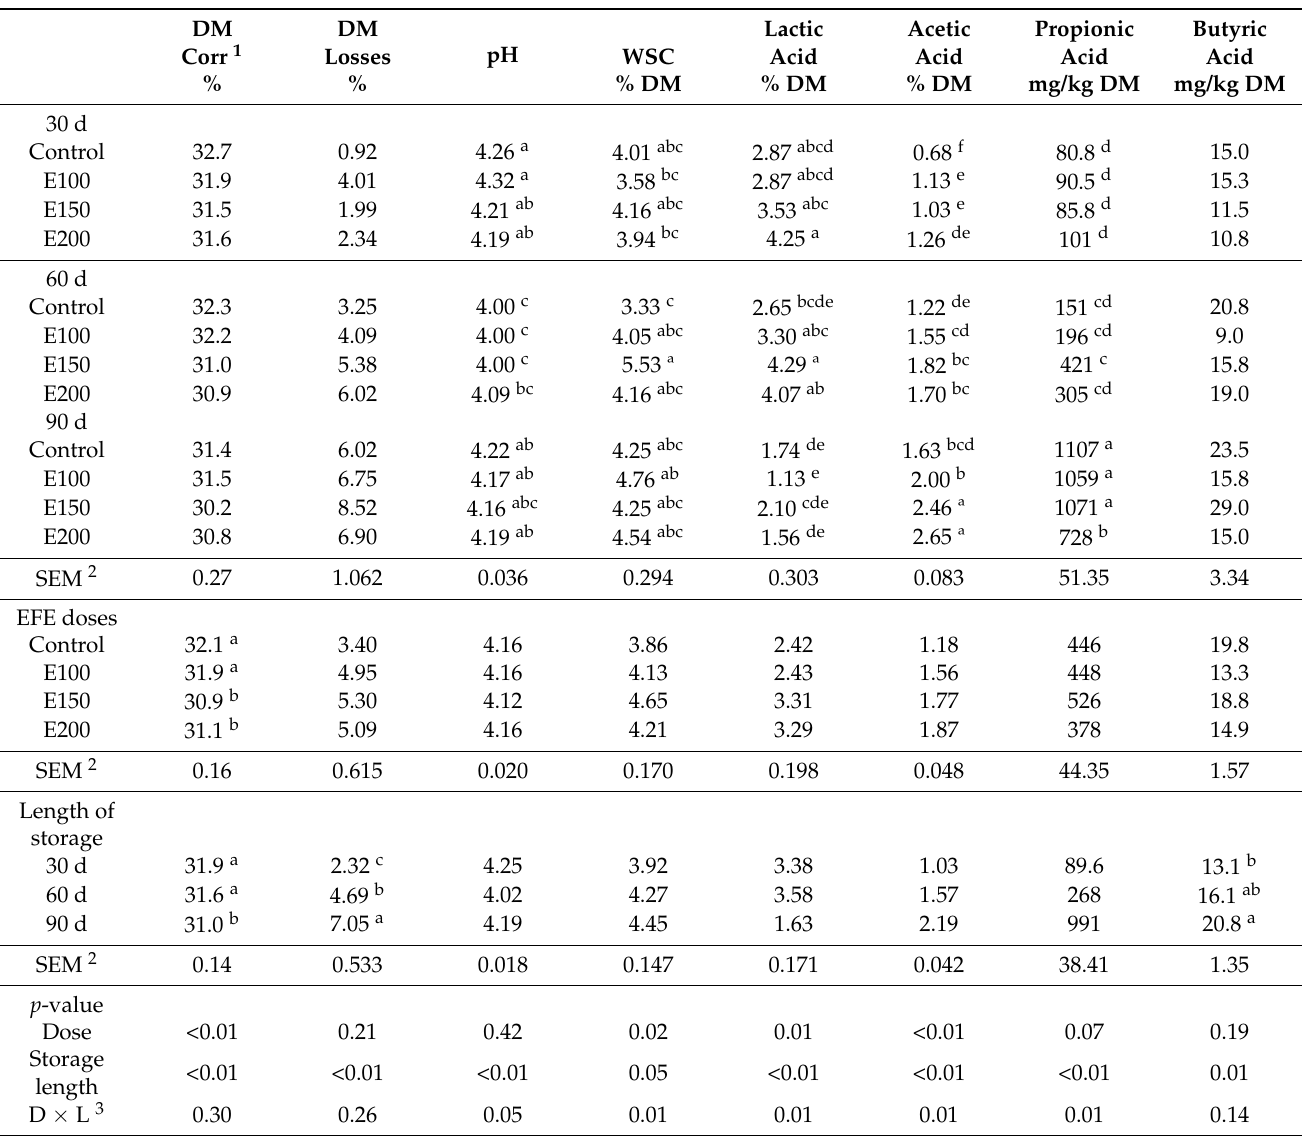
Table 2. Fermentation characteristics of maize silages treated with exogenous fibrolytic enzymes (EFEs) at 0, 100, 150 and 200 g/ton of DM ensiled for 30, 60 and 90 days. Lactic Acetic Propionic